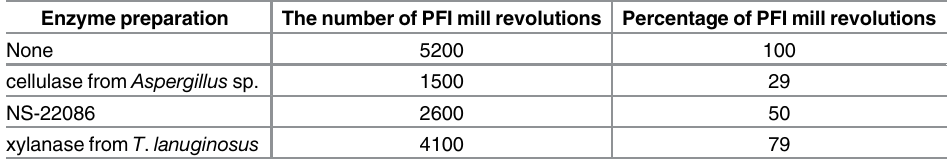
The numbers of mill revolutions required to achieve the pulp freeness value of 30°SR are compared in Table 3. The effect of enzymatic pulp treatment with Aspergillus sp. cellulase on pulp freeness was stronger than in case of NS-22086 preparation and T . lanuginosus xylanase (the weakest impact despite the highest cellulolytic and xylanolytic activities used per 1 g d.w. pulp). However, apart from the refined pulp freeness also other parameters such as WRV, aver- age fiber length and fines content decide of paper properties. The data shown in Fig 1B demonstrate that the treatments with the Aspergillus sp. cellulase and preparation NS-22086, which contains enzymes hydrolyzing cellulose and xylan, caused that the swelling ability (expressed as WRV) grew significantly faster during refining, com- pared to the untreated pulp. The influence of T . lanuginosus xylanase on the growth of this parameter was not so strong. Also the level of fines in the refined pulp was only slightly affected by this enzyme, and interestingly, at the end of pulp refining the percentage of fines was lower the pulp processed with the xylanase than in the untreated pulp (12.8% d.w. versus 13.4% d.w., respectively). The modification of fibers structure by Aspergillus sp. cellulase caused that the percentage of fines was above 70% after around 2000 revolutions of the PFI mill and the resulting refined pulp was useless for paper production. At the freeness of 30°SR the pulp treated with the latter preparation contained as much as 54.5% fines while that treated with NS-22086 preparation contained around twice more fines than the untreated pulp (23.8 versus 13.4% d.w.). The positive effect of pulp treatment with Aspergillus sp. cellulase and NS-22086 prepara- tion before refining on the growth of pulp freeness is in compliance with results reported among others by Cui et al. [13]. Based on experimental results and literature data these authors concluded that the impact of various enzyme preparations on pulp and paper parameters depended on a balance between activities of cellulases and hemicellulases. Our study revealed that pulp treatment with the three enzyme preparations caused the rise in WRV of the pulp during refining and that the impact of T . lanuginosus xylanase was weaker than the influence of the two cellulases. However, at the end of refining (at the freeness of 30°SR) this parameter was the highest for the untreated pulp (Table 4) while in the study of Liu et al. [14] WRV